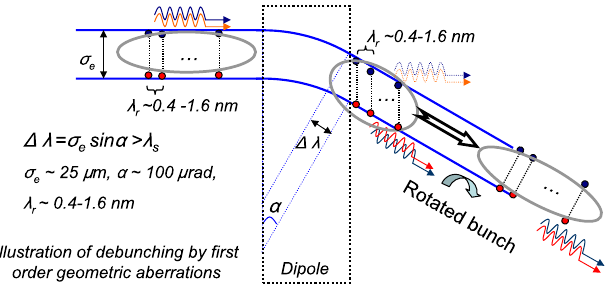
FIG. 1. (Color) Illustration of the bending of a circularly sym- metric macrobunch subdivided into microbunch slices by a single dipole. The slices of the microbunches are indicated. The microbunching is only preserved along the original direc-